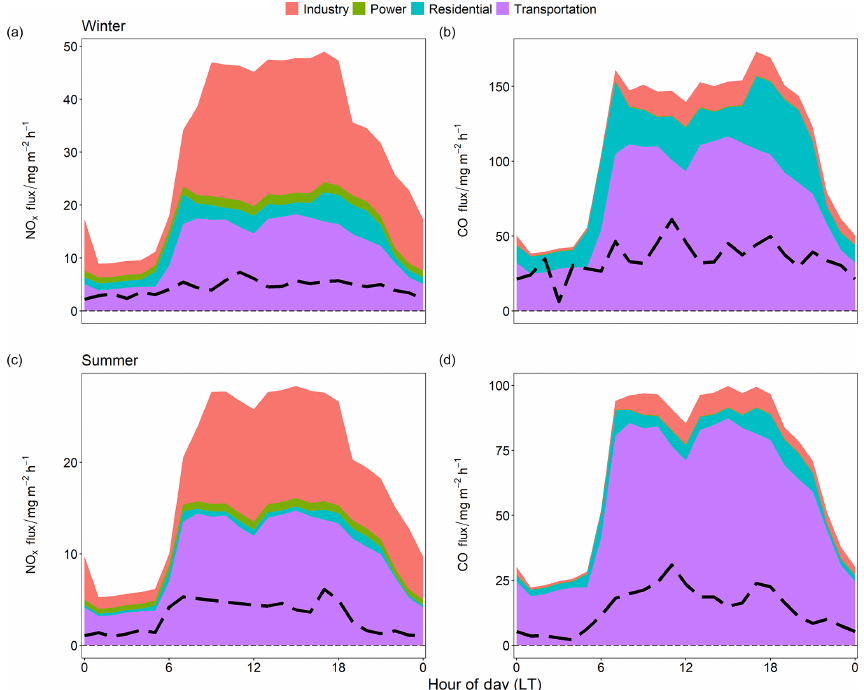
Figure 10. Measured diurnal trend (dashed black line) and predicted diurnal trend using the MEIC inventory (filled areas by sector) for NO x and CO emissions. MEIC inventory data have been reduced by 30% for comparison with the winter 2016 campaign and by 43% for comparison with the summer 2017 campaign to take account of expected emissions reductions indicated in Cheng et al. (2019). Panels (a) and (b) show emissions for the winter campaign and panels (c) and (d) show emissions from the summer